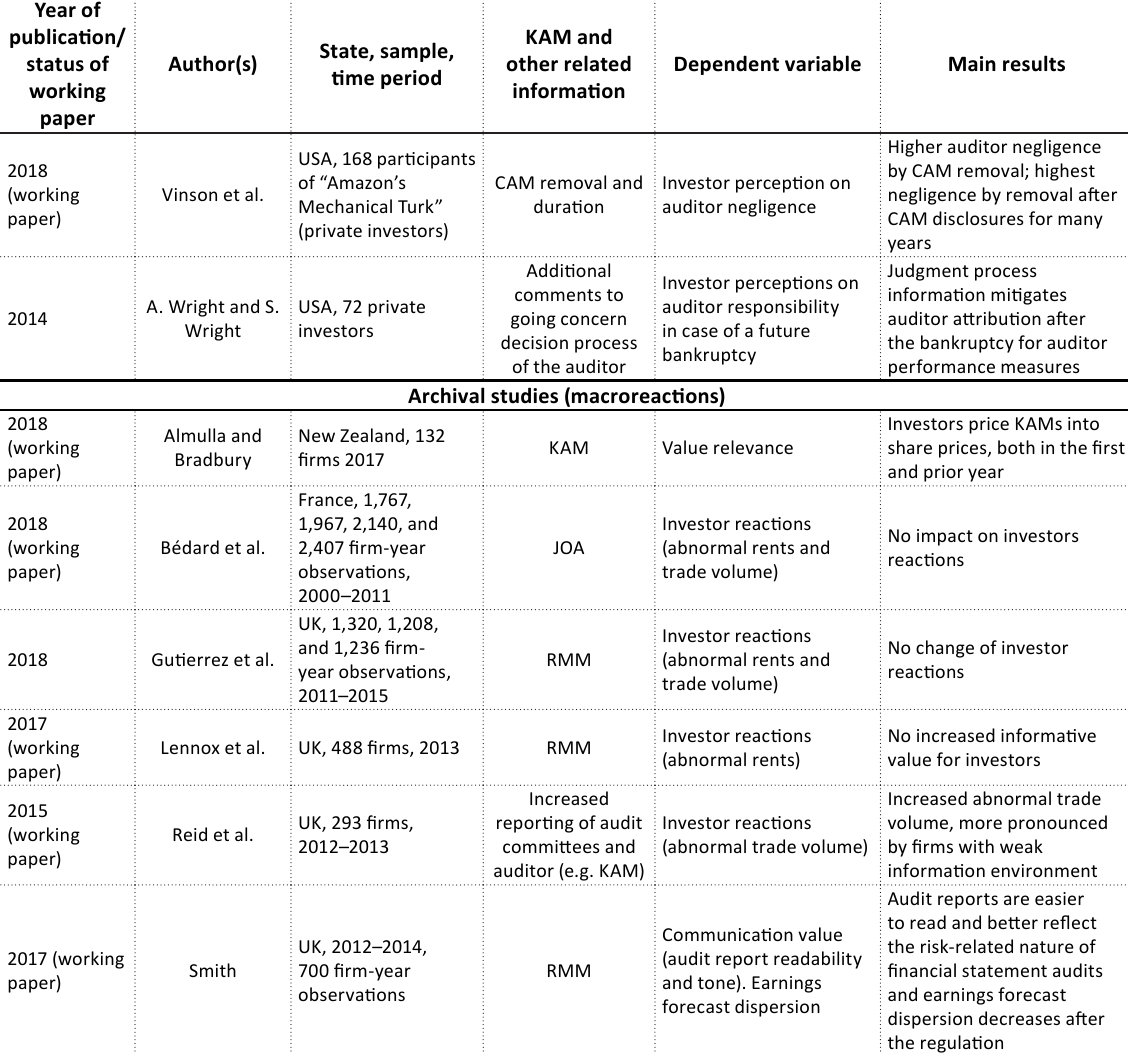
Table 3 (cont.). Overview of empirical research regarding the impact of KAM and other related information on